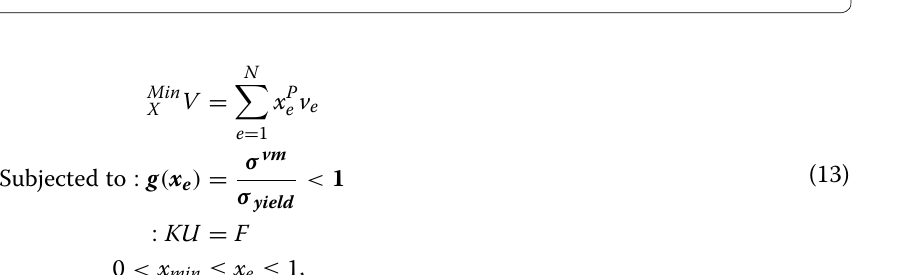
Fig. 4 Two-dimensional element stress